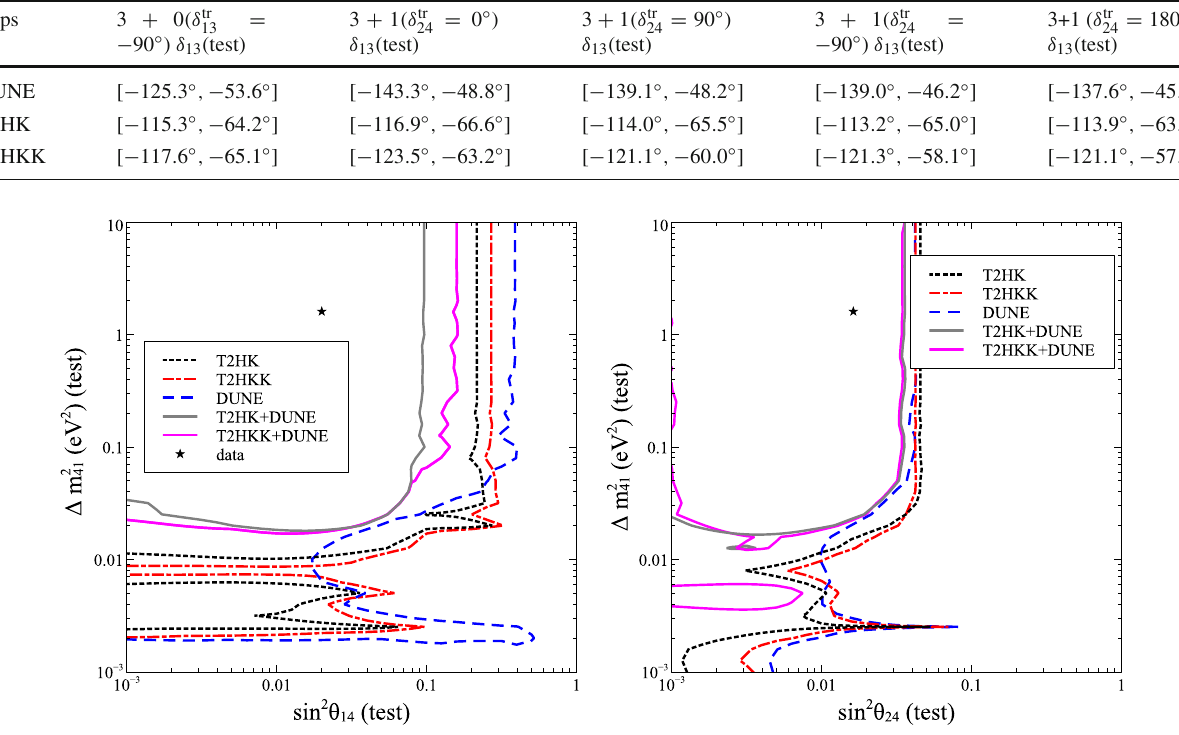
Table 2 The 2 σ allowed δ 13 (test) ranges for the three experiments both in 3 + 0 and 3 + 1 scenario. In both the scenarios, assumed true value of δ − 90 ◦ while in 3 + 1 case, we give the allowed ranges of δ 13 is